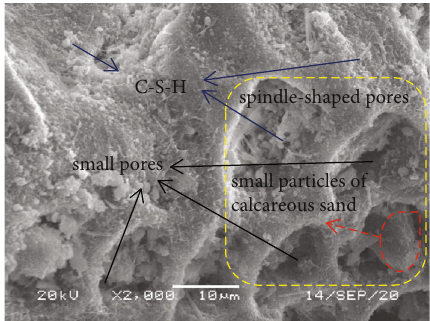
Figure 8: Microscopic features of CCS.